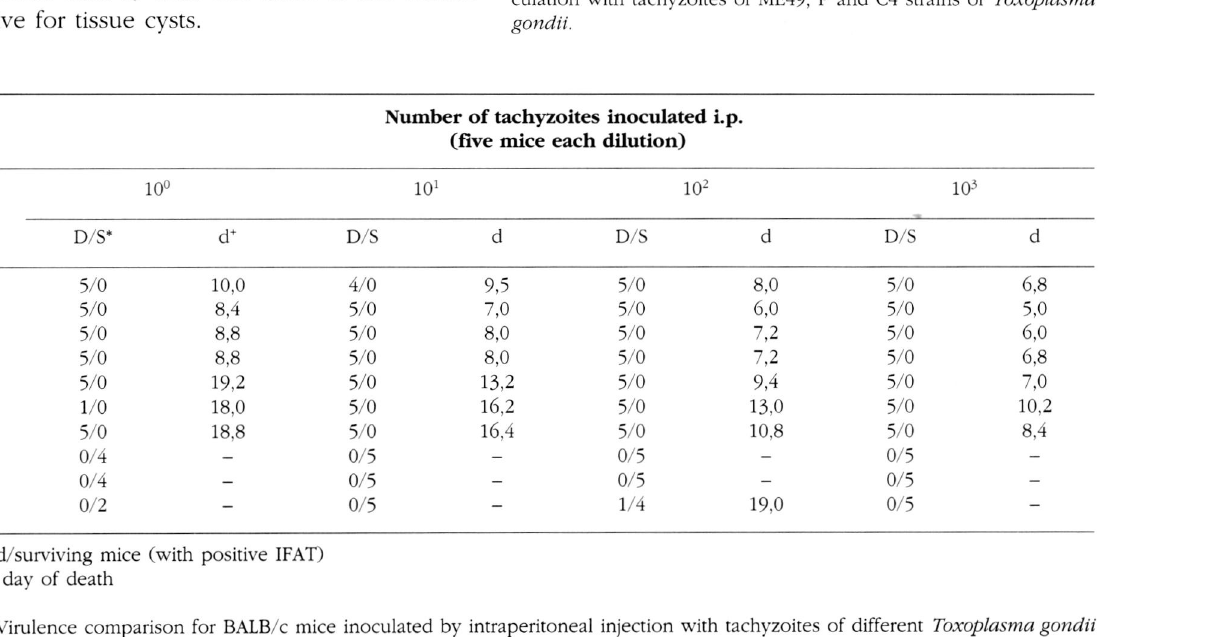
Table II. - Virulence comparison for BALB/c mice inoculated by intraperitoneal injection with tachyzoites of different Toxoplasma gondii